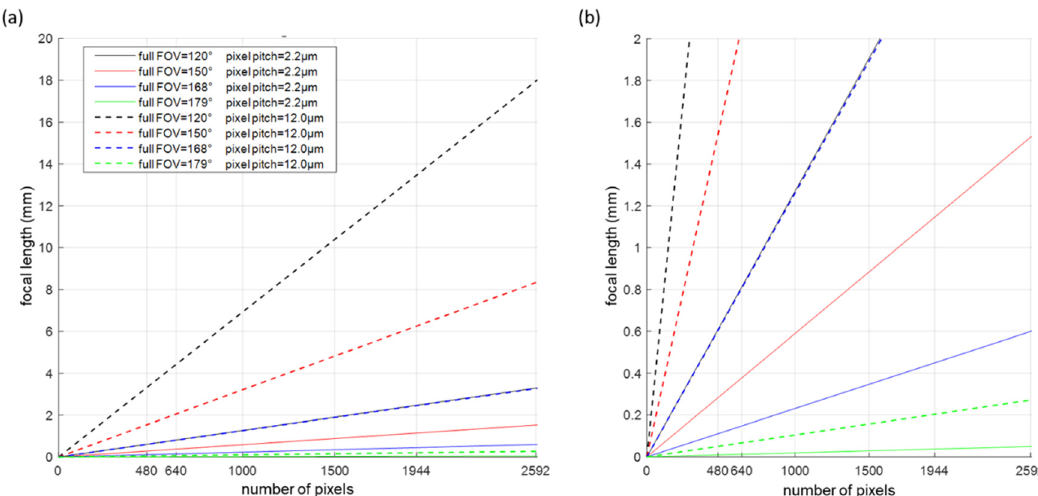
Figure 3. Lens focal length as function of the number of pixels, when using a working distance of 30 m: ( a ) a full FOV from 120° up to 179° and a pixel pitch of 2.2 µm and 12 µm; ( b ) a closeup of ( a ) but at up to 5292 pixels. In general, a linear scaling of the design can be observed.